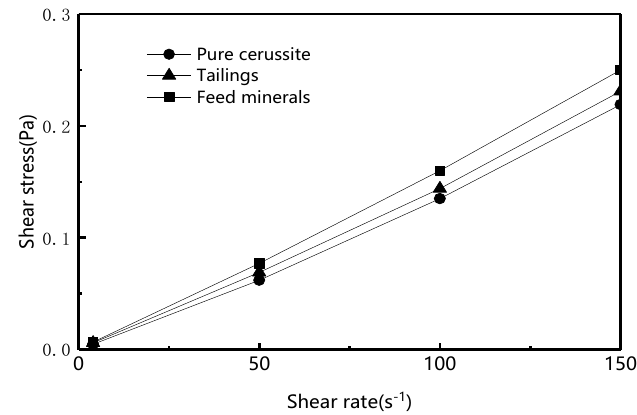
Figure 2. Rheological curve of pure cerussite (dots), flotation feed (square) minerals and tailings (triangle) with mass concentration of 35%.